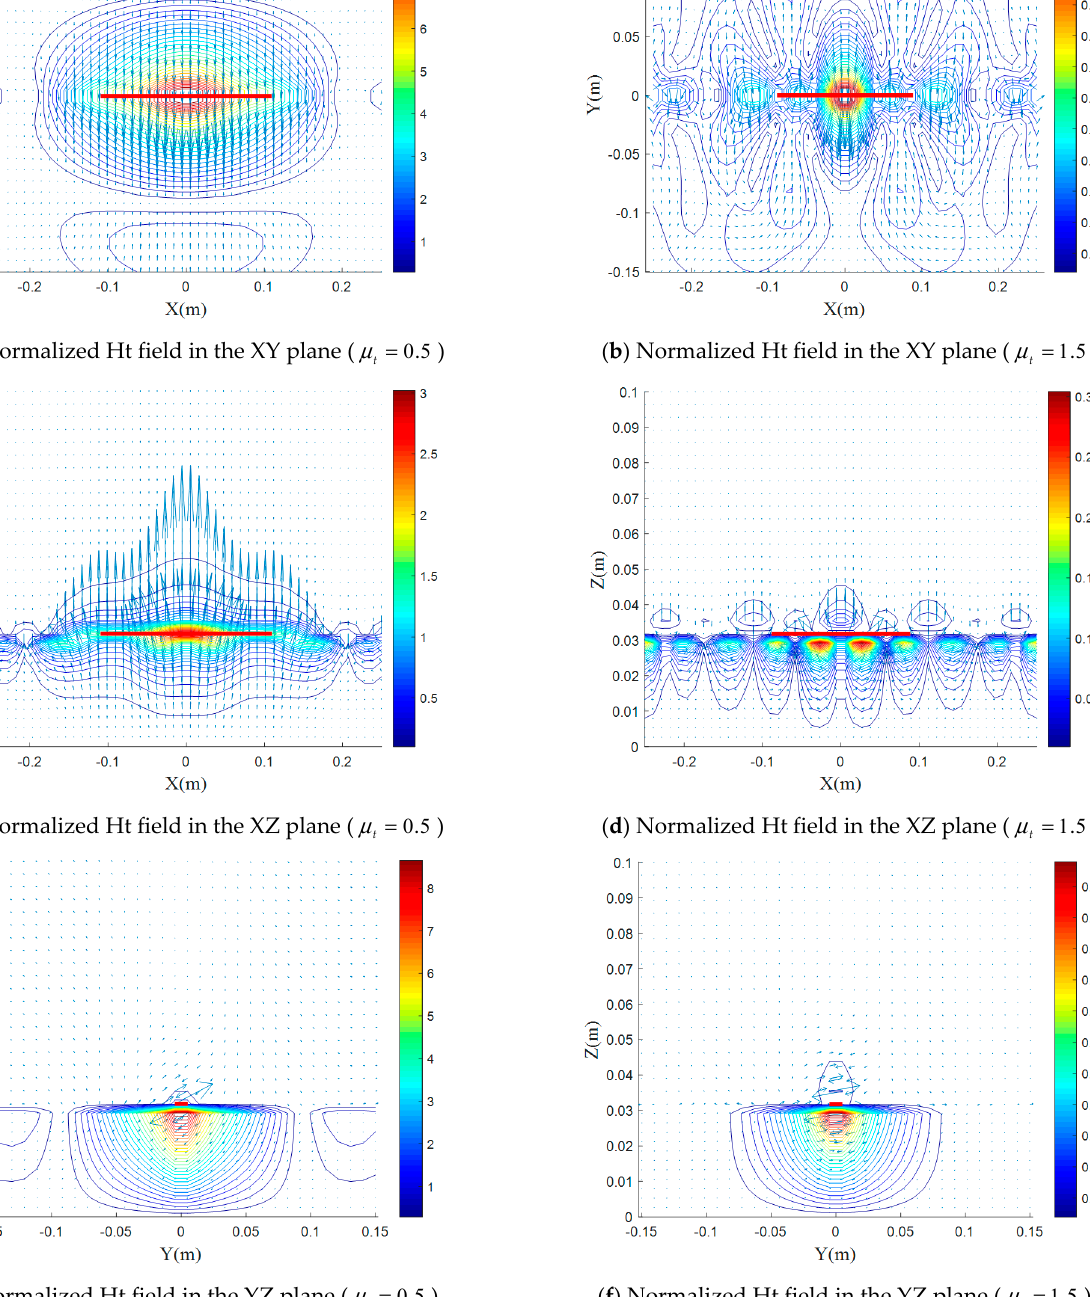
μ with 253 . == εε and 1 = μ , in the t tz z